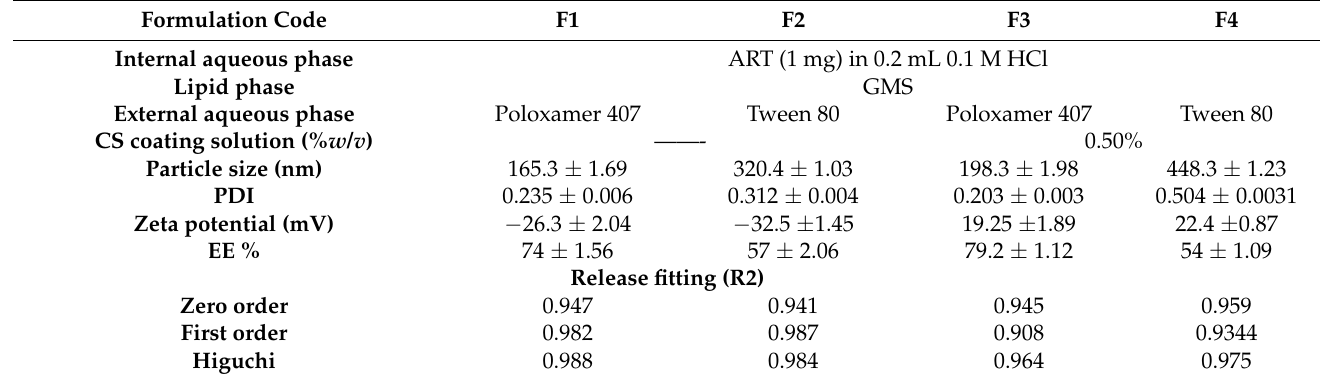
Table 2. SLNs composition, particle size, PDI, EE % and release order.